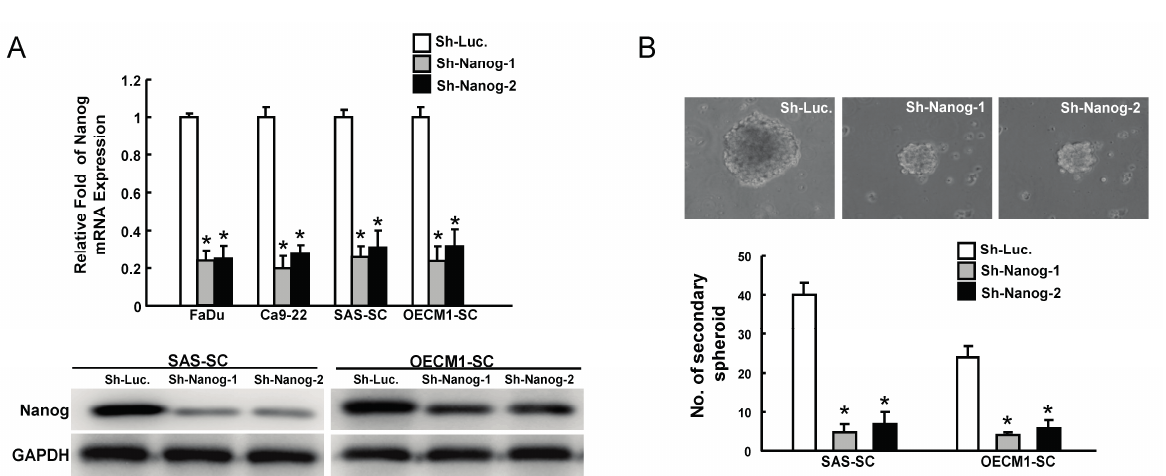
Figure 2. Targeting Nanog effectively abrogates the oncogenicity of HNSCC cells and HNSCC-spheroid cells (SCs). ( A ) The silencing effect of Nanog-shRNA in HNSCC cells and HNSCC-SCs was validated by real-time RT-PCR analysis and western blotting. Control and Nanog-knockdown HNSCC-SC were subjected to a secondary spheroid assay; ( B ) To elucidate the capability of cell invasiveness ( C ) and anchorage independent growth ( D ) of HNSCC-SC, HNSCC-SC with Nanog downregulation, single-cell suspension of HNSCC-SC infected with Nanog-specific shRNA or control sh-Luc lentivirus for three days were plated onto transwell and transwell coated with matrigel and soft agar, respectively, and analyzed as described in the Materials and Methods. Results are the means ± SD of triplicate samples from three experiments; and ( E ) Nude mice were subcutaneously injected with control and Nanog-knockdown SAS-SC, and the mice were monitored for six weeks of tumor development ( n = 6). * p <